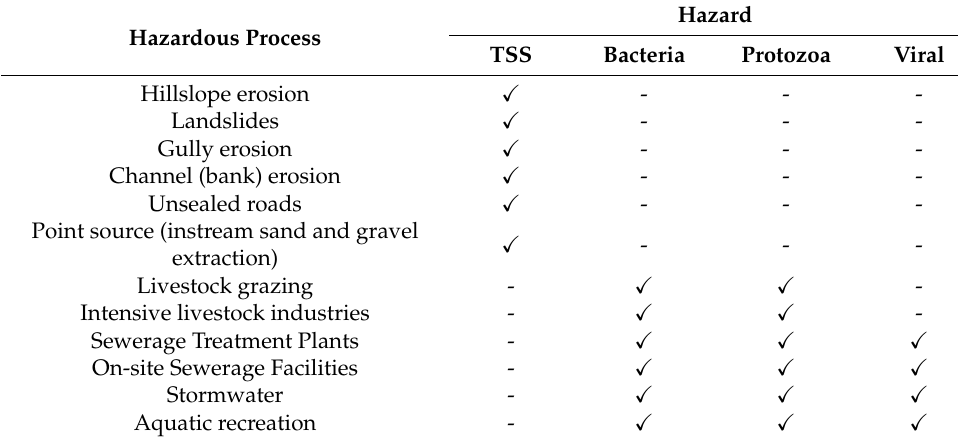
Table 2. Hazardous processes for each hazard to drinking water quality considered in the Catchment Investment Decision Support System